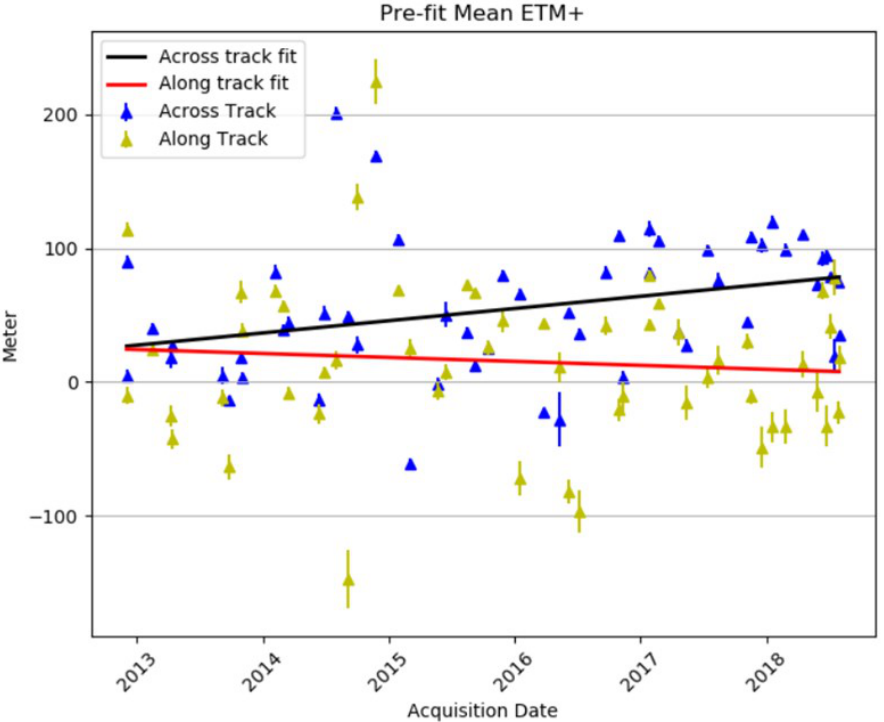
Figure 15. Geodetic accuracy pre-fit mean results for the verification scenes prior to calibration. An upward trend for the across track direction is shown as a black line within the plot and follows the trend shown in Figure 12.